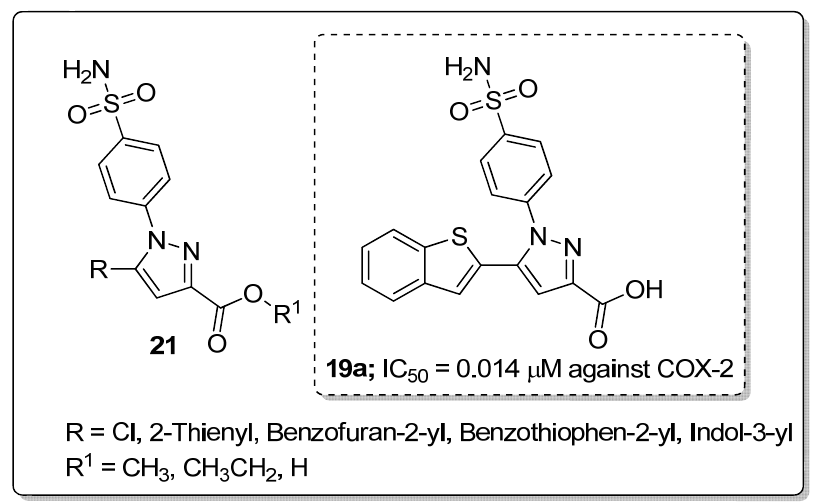
Figure 25. Anti ‐ inflammatory activity of the most active pyrazole sulfonamide conjugate 21a .